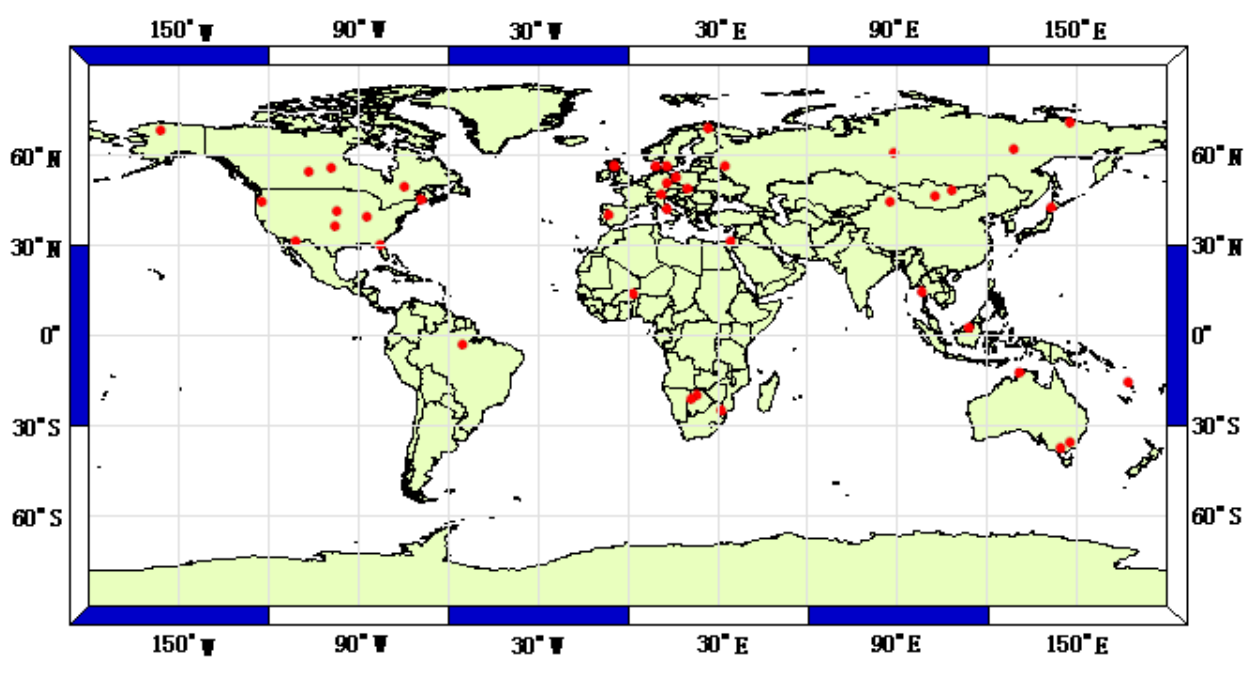
Figure 2. Location of the 40 flux tower sites used in this